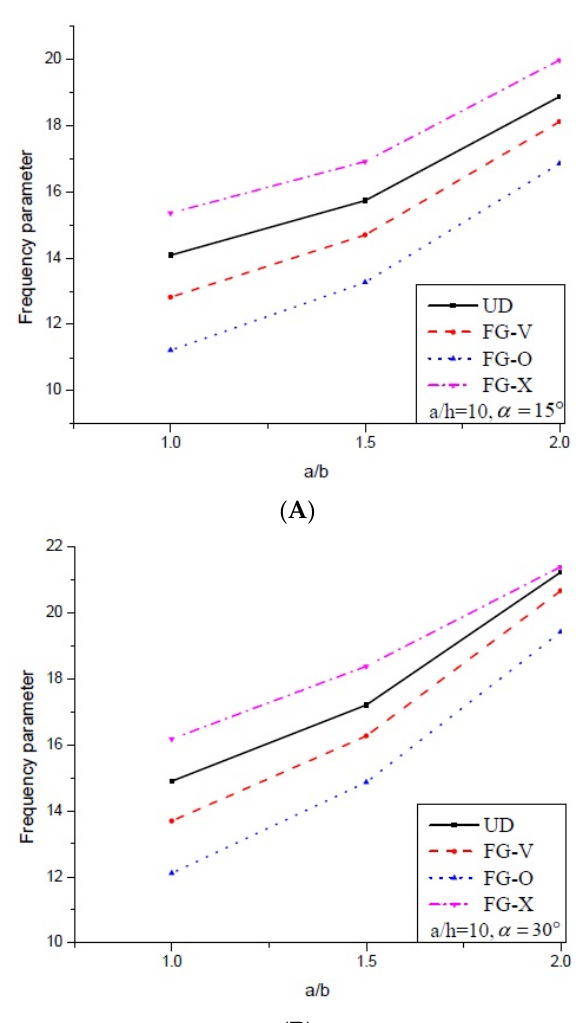
Figure 3. Variation of non-dimensional frequency parameter of FG-CNT-reinforced rhombic plate with aspect ratio; ( A ) α = 15° and ( B ) α = 30°